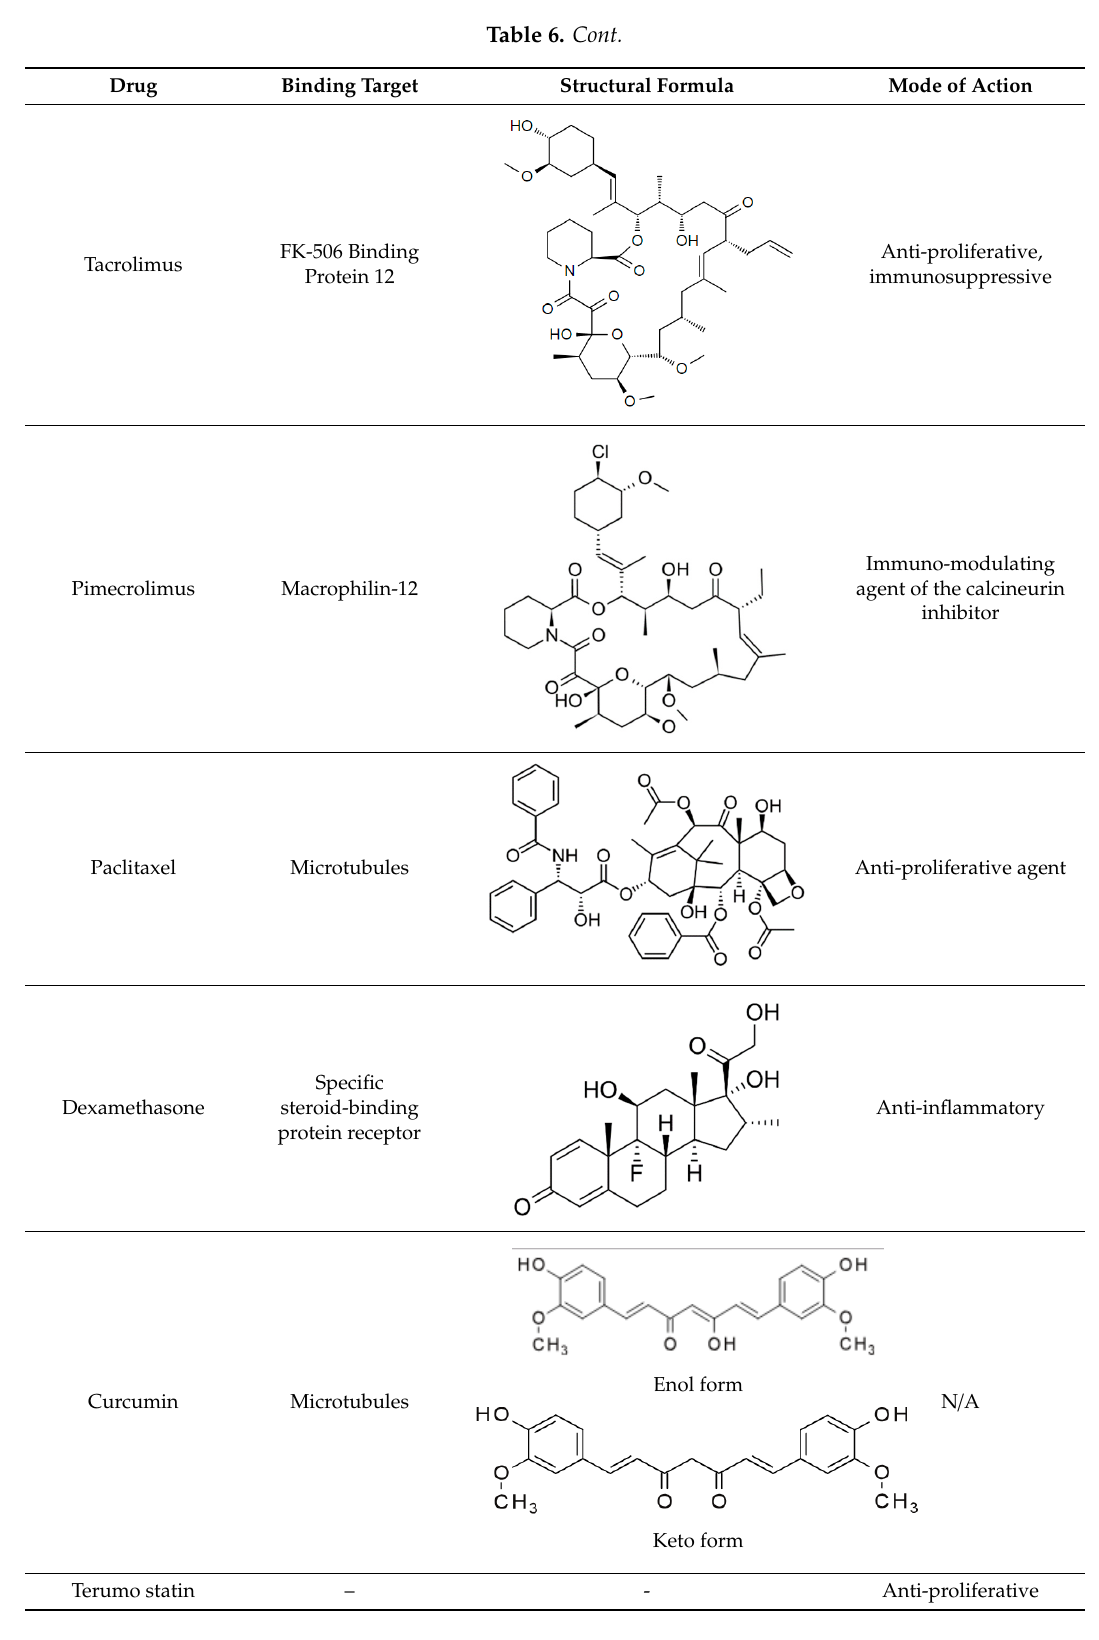
Table 6. Drugs commonly used in